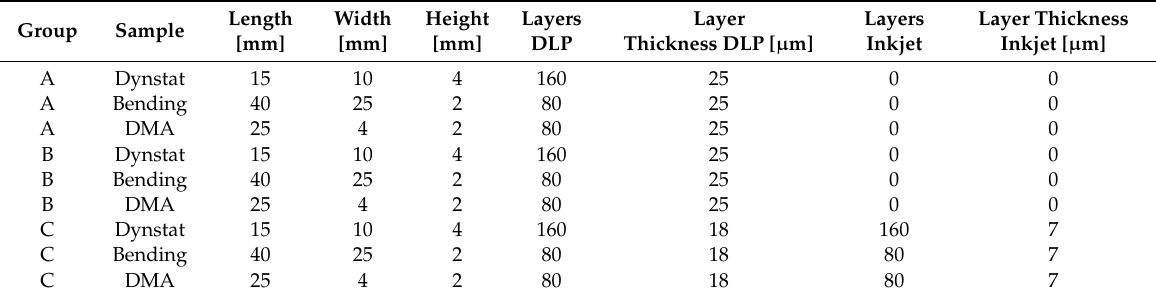
Table 3. Dimensions, number of layers, and calculated layer thickness for all test